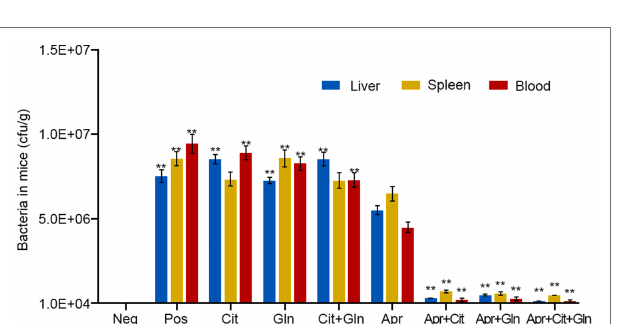
FIGURE 4 | Effects of exogenous citrulline and glutamine combined with Apramycin in the mice infection model. “Pos” represents positive control group; “Cit” represents mice treated with citrulline alone, “Gln” represents mice treated with glutamine alone, “Cit + Gln” represents mice treated with citrulline and glutamine, “Apr” represents mice treated with Apramycin alone, “Apr + Cit” represents mice treated with Apramycin and citrulline, “Apr + Gln” represents mice treated with Apramycin and glutamine, and “Apr + Cit + Gln” represents mice treated with Apramycin, citrulline, and glutamine. Results are displayed as the mean ± SEM, and significant differences are identified (** p < 0.01, compared with the mice treatment with Apramycin alone) as determined using SPSS Statistics